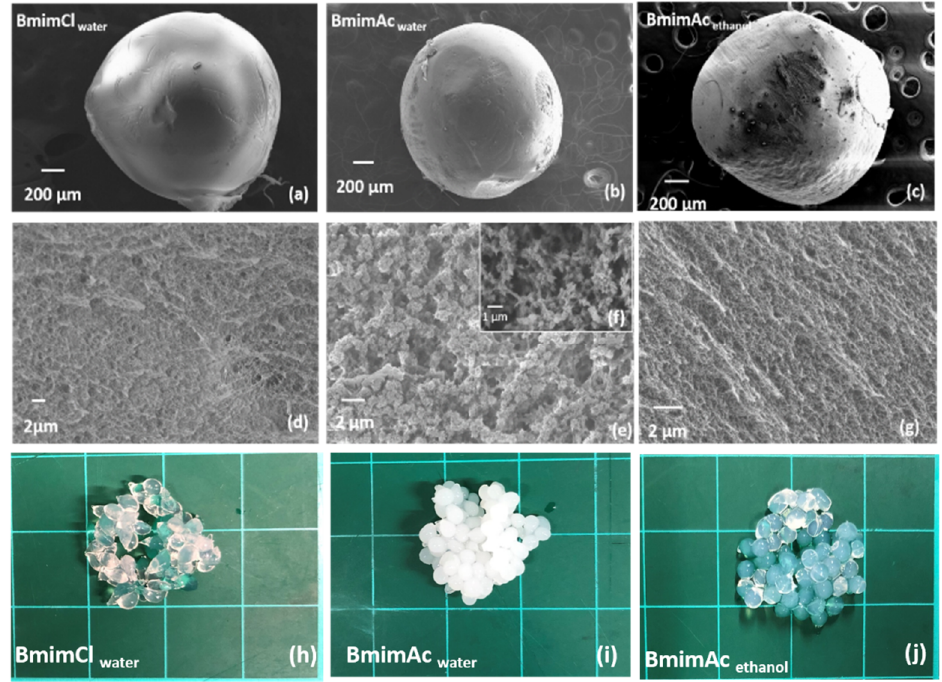
Figure 2. Scanning electron microscopy (SEM) images of surfaces ( a – c ) and cross sections ( d – g ) of cellulose beads prepared from denim; ( a ) and ( d ) Bmim Cl water ; ( b ), ( e ) and ( f ) Bmim Ac water ; ( c ) and ( g ) Bmim Ac ethanol . ( h – j ) present the appearances of cellulose beads.